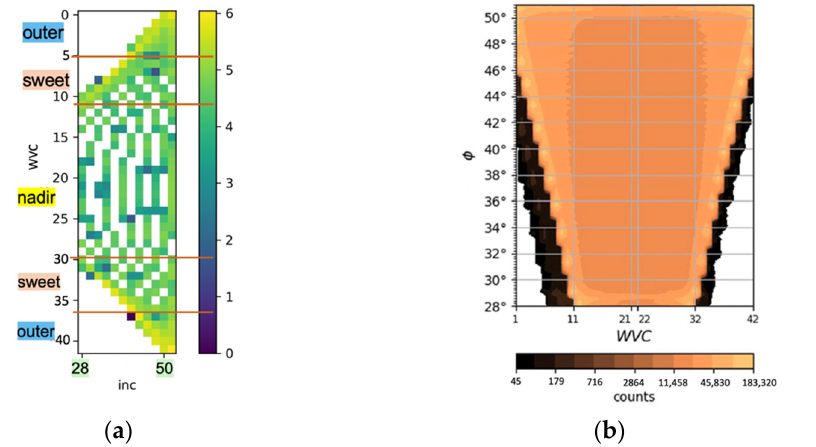
Figure 7. The probability distribution of MLE ice in the selected WVCs across the swath: outer WVCs number 1 and 42; sweet WVCs number 6 and 36; nadir WVC number 21.